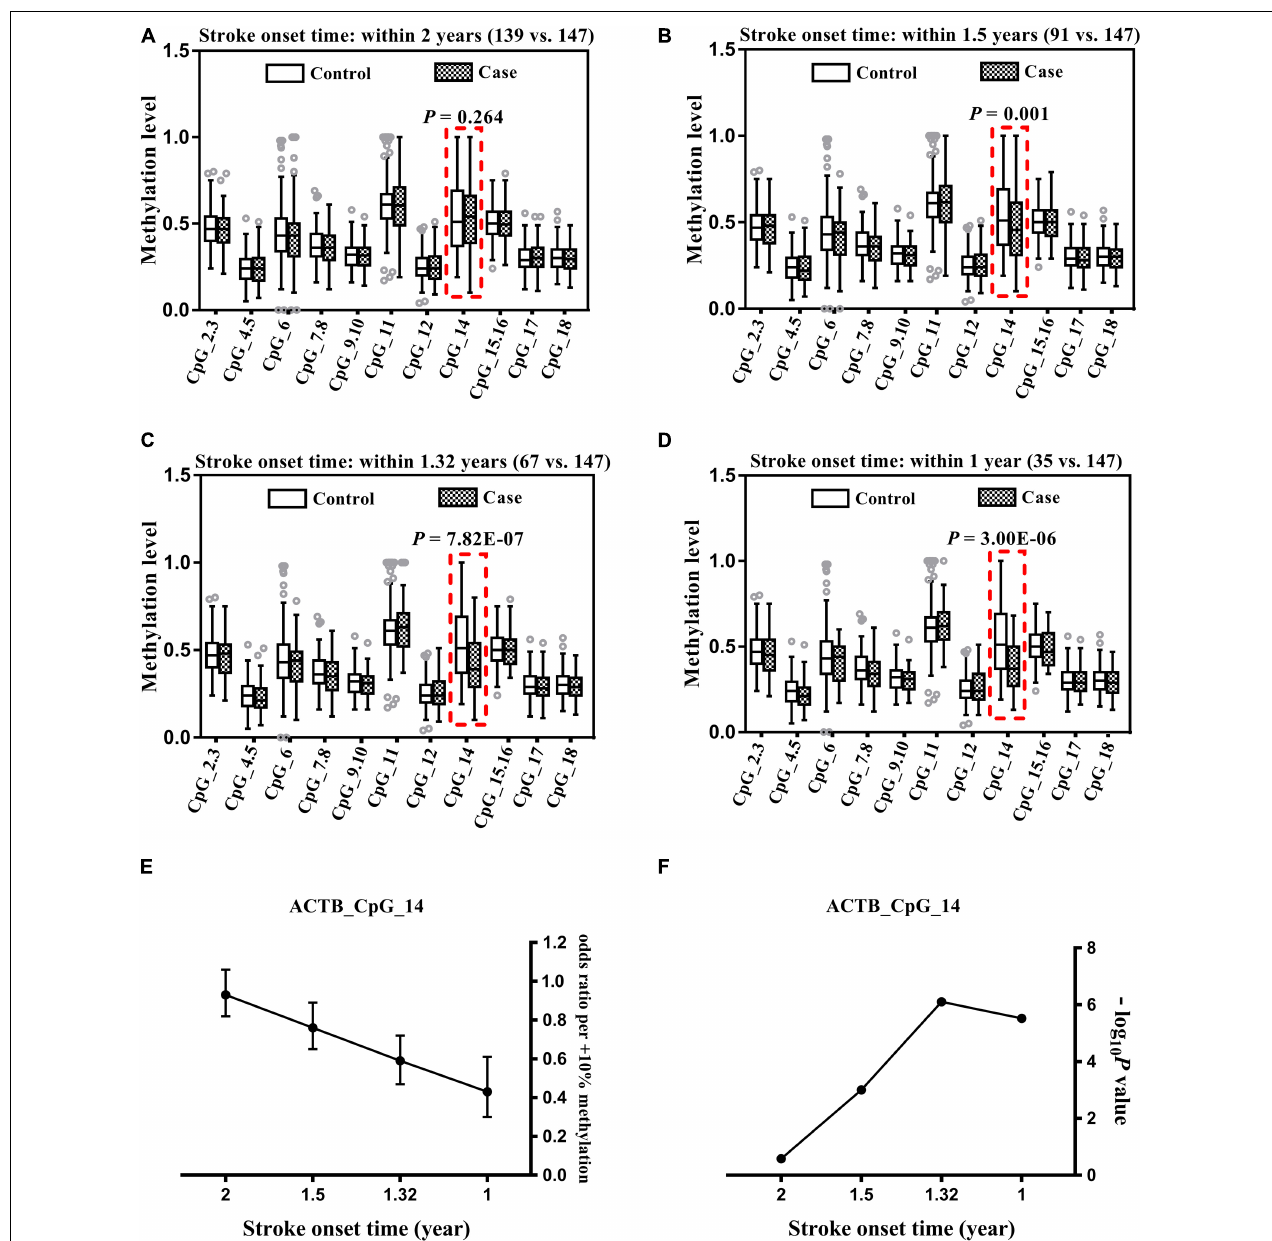
FIGURE 1 | Association between ACTB methylation in peripheral blood and stroke. The analysis was performed for stroke cases with onset time < 2 years (A) , ≤ 1.5 years (B) , ≤ 1.32 years (C) , and ≤ 1 year (D) . The box plots show the distribution of ACTB methylation levels in stroke cases and controls. The P -values were calculated by logistic regression adjusting for BMI, smoking, drinking, hypertension, diabetes, TC, TG, HDL-C, LDL-C, leukocyte counts and proportions of neutrophil, lymphocyte and monocyte. The circles indicate outliers. (E) The OR per + 10% methylation of ACTB_CpG_14 in stroke cases with onset time < 2, ≤ 1.5, ≤ 1.32, and ≤ 1 year were based on logistic regression analysis adjusting for BMI, smoking, drinking, hypertension, diabetes, TC, TG, HDL-C, LDL-C, leukocyte counts and proportions of neutrophil, lymphocyte and monocyte. (F) The P -values of association between ACTB_CpG_14 and stroke cases with onset time < 2, ≤ 1.5, ≤ 1.32 and ≤ 1 year transformed by -log 10 P